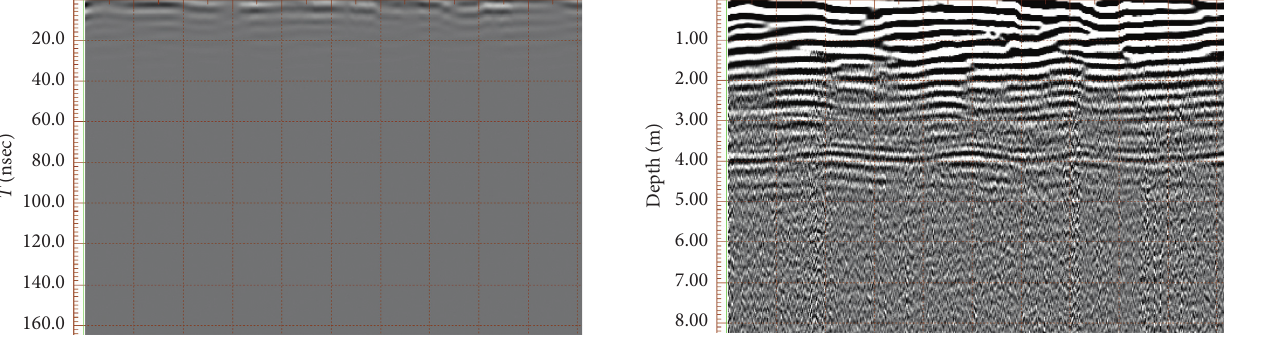
Figure 11: Radar image after removing the background noise.